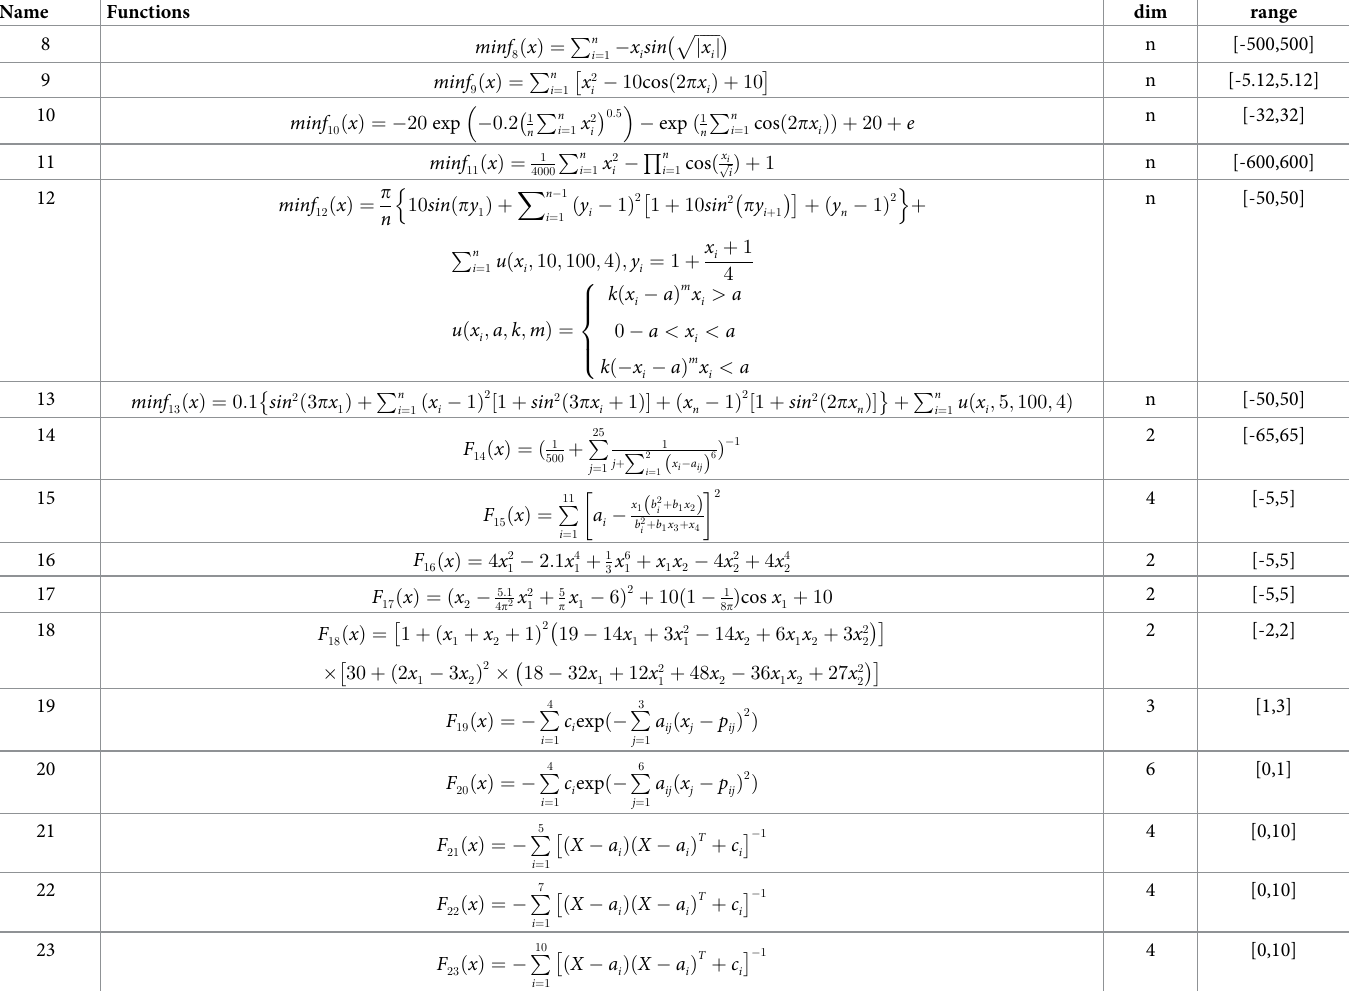
Table 3. Multimodal benchmark